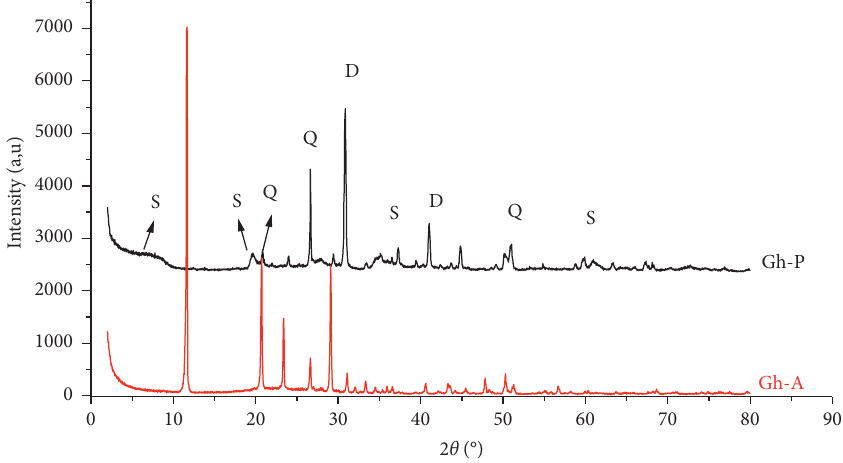
Figure 1: XRD patterns of Gh-P and Gh-A.